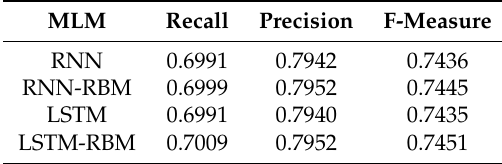
Table 6. Results for MLMs on the real piano “ENSTDkCl”.